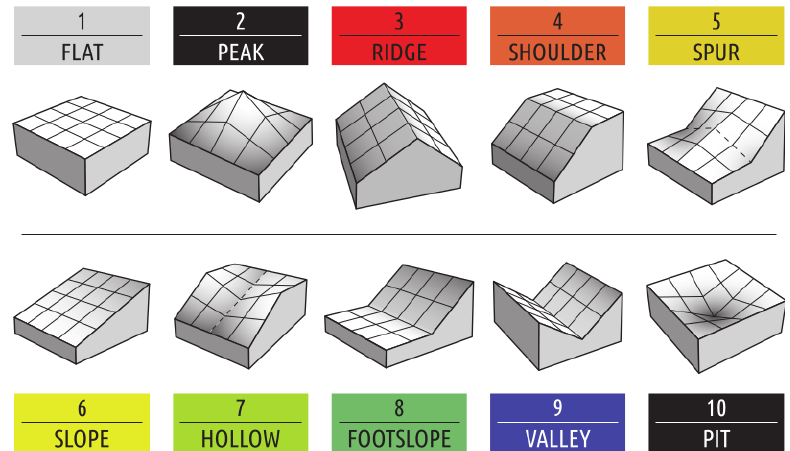
Figure 2. The r.geomorphon algorithm classifies every grid cell of a given digital terrain model as one of these 10 landforms based on line-of-sight calculations (figure based on